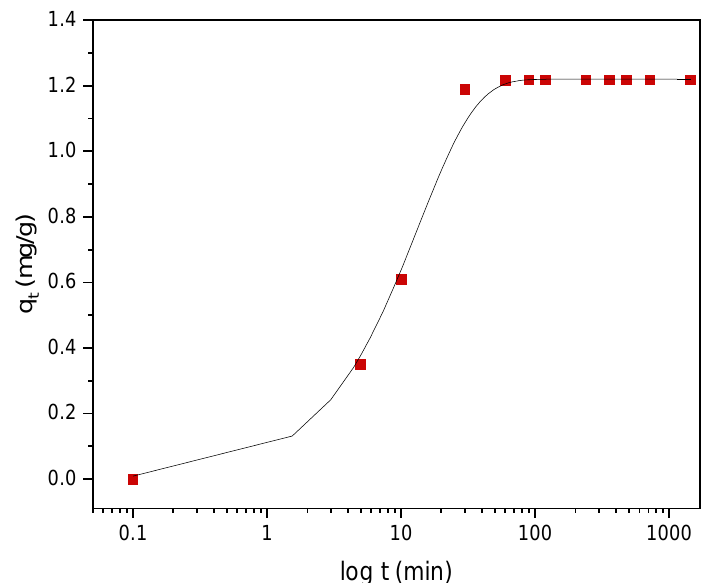
Figure 9. The dependence of the adsorption capacity (red squares) of DO on the contact time with plasma-treated LDPE. Black line represents the nonlinear, pseudo-first-order (PFO) kinetic model.